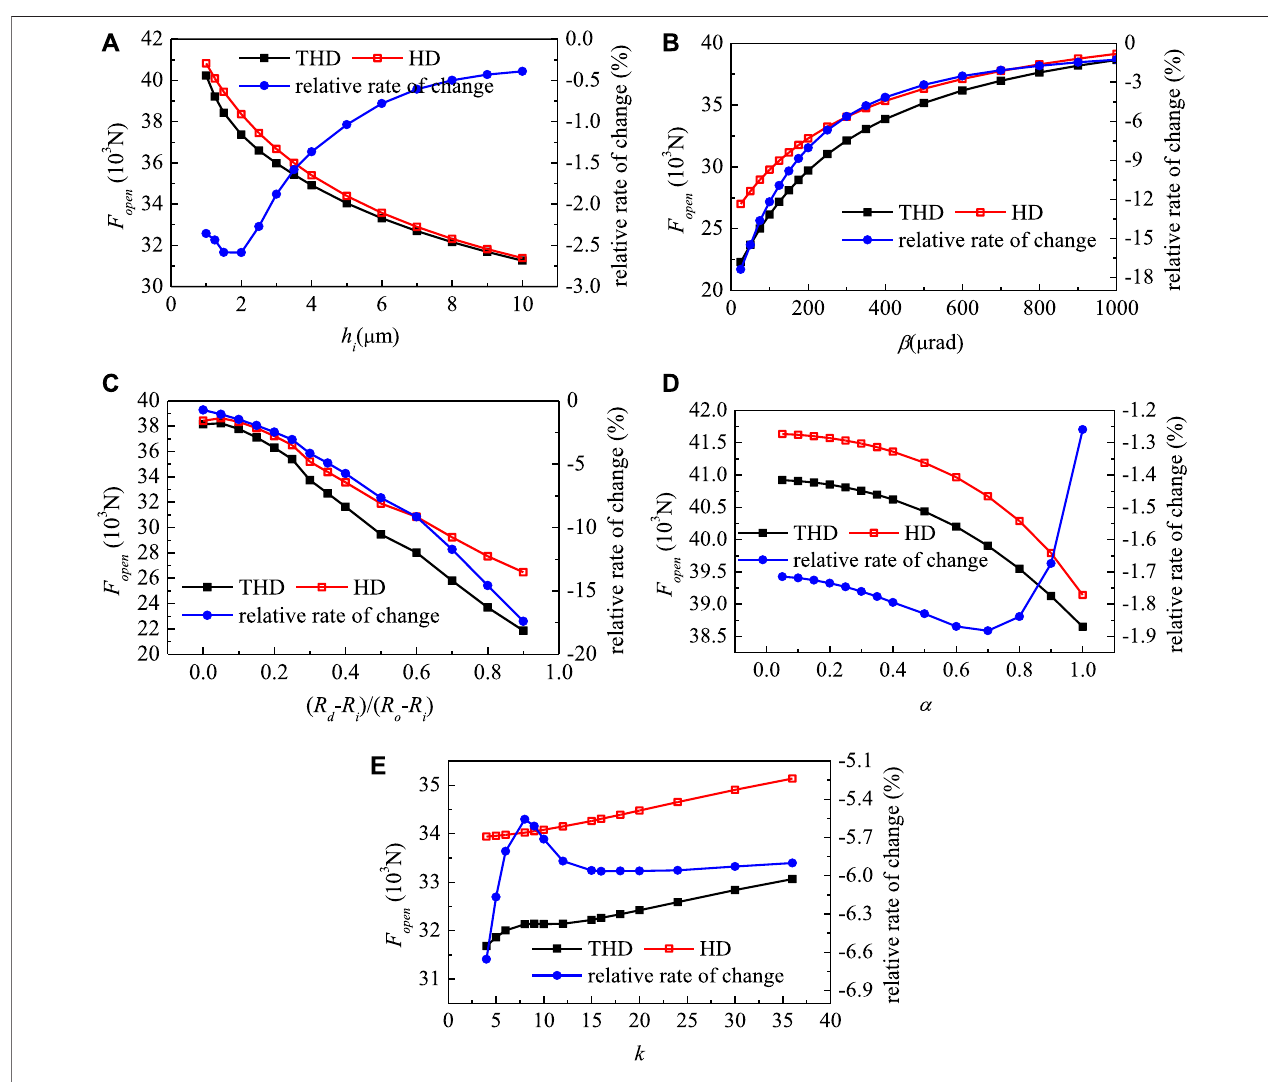
FIGURE 5 | Effect of structural parameters on the opening force under the viscosity-temperature effect.